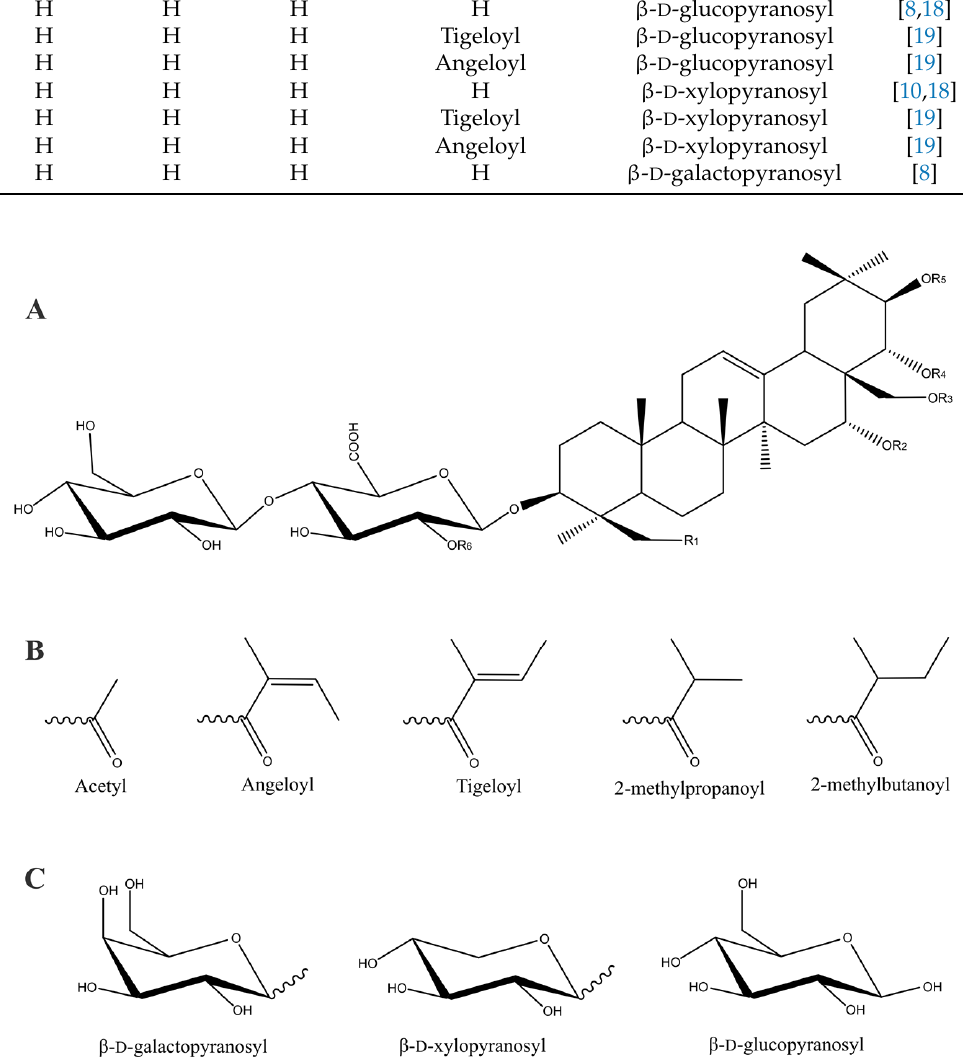
Figure 1. General chemical structure of escin ( A ), structures of various acid moieties ( B ) and sugar units ( C ) found in escin.